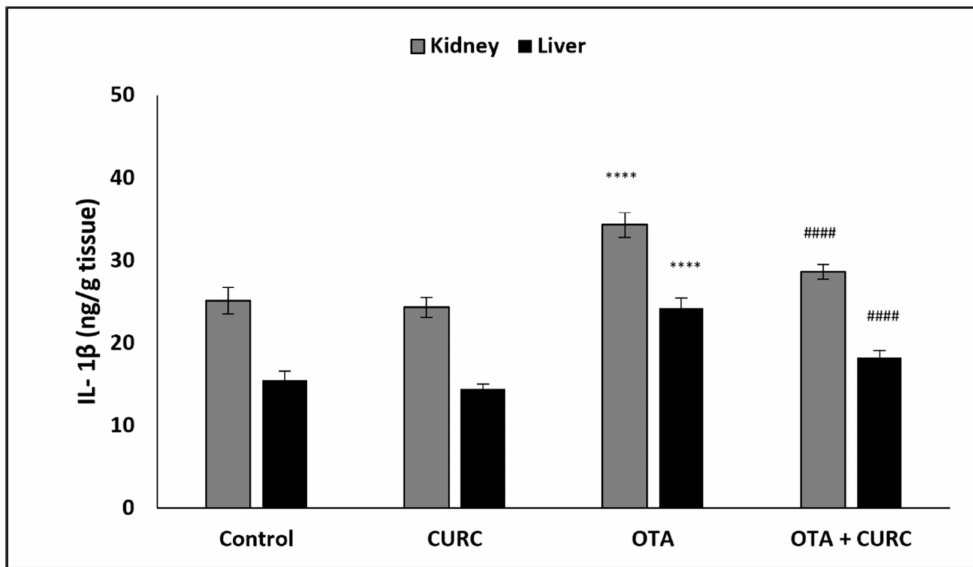
Figure 6. Effect of curcumin (CURC) on kidney and liver interleukin-1 β (IL-1 β ) level in different experimental groups after 14 days of treatment. Control group; CURC group (100 mg/kg b.w. of CURC); OTA group (0.5 mg/kg b.w. of OTA); OTA + CURC group (0.5 mg/kg b.w. of OTA plus 100 mg/kg b.w. of CURC). Data are expressed as mean ± standard deviation (SD) of n = 6 rats in each group (**** p < 0.0001 vs. control; #### p < 0.0001 vs.